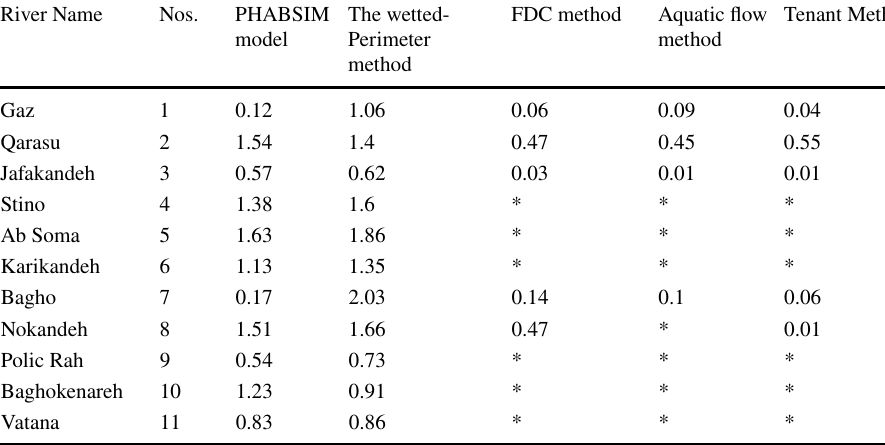
Table 3 The mean annual values of EWR (m 3 /s) for the rivers of the Miankaleh wetland